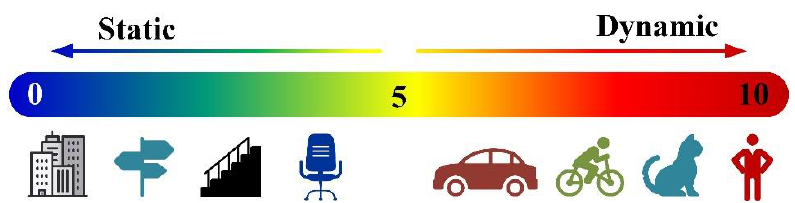
Figure 2. Based on life experience, the dynamic degree of common objects is scored. Only a few common objects are listed. The threshold is set to 5. If the detection score of an object is higher than the threshold, it is considered as a dynamic object, otherwise we think it as a static object.